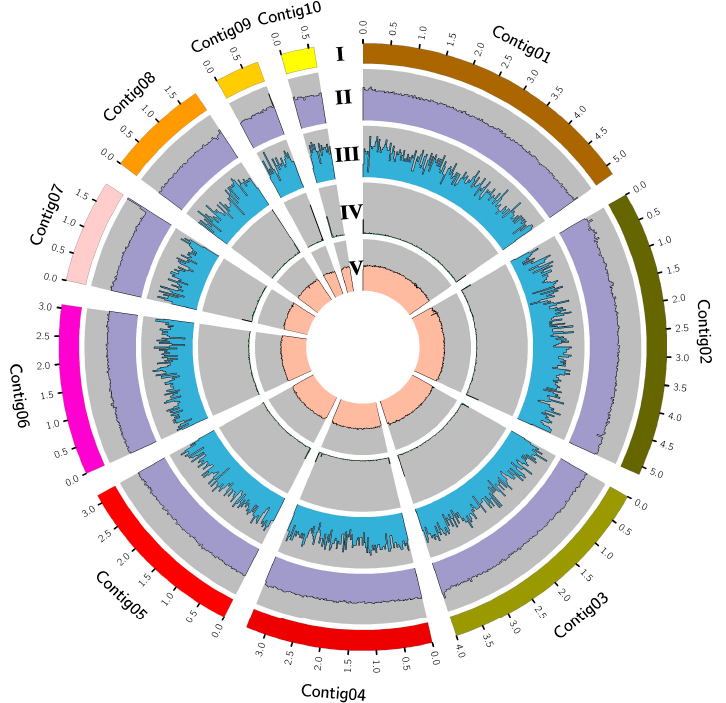
Figure 3. Circos-plot showing the genomic features of Simplicillium lamellicola JC-1. I , contigs larger than 0.5 Mb in length; II , frequency of distribution of reading coverage (scale: 0 to 200×); III , gene density (scale: 0 to 20); IV , repeat density (scale: 0 to 100%); and V , G + C content (scale: 0 to 100%). All statistics are based on non-overlapping windows (size = 30 kb).